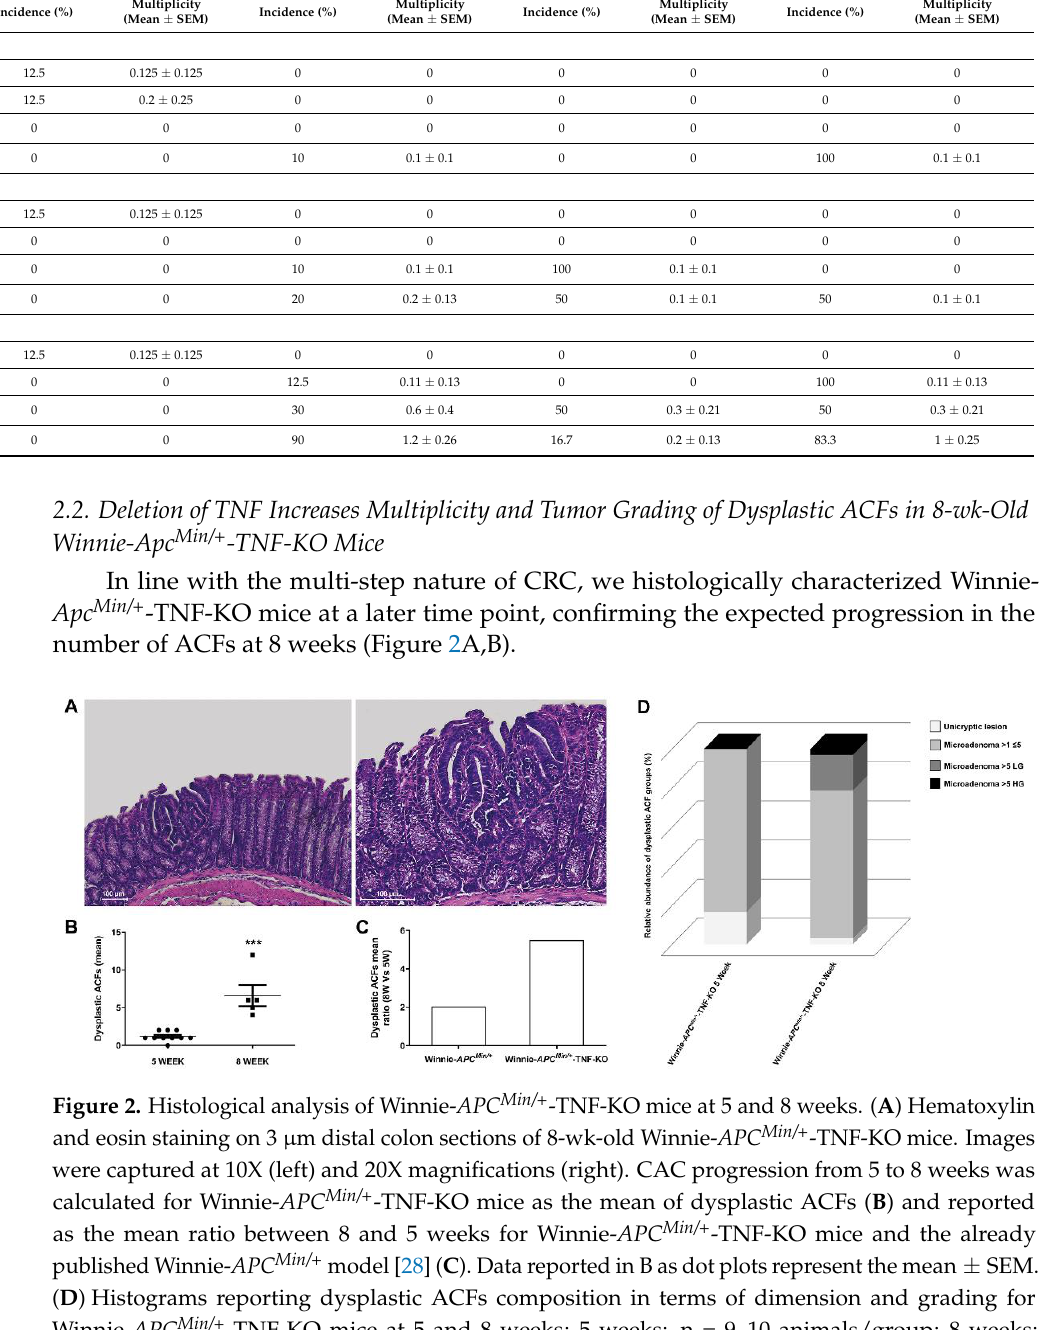
Table 1. Histological analysis of 5-week-old Winnie- APC Min/+ -TNF-KO mice and control littermates. Incidence and multiplicity ± SEM of proximal, medial, and distal colon were calculated for non- dysplastic and dysplastic ACFs. The score for dysplastic ACFs was calculated relative to all groups, and each group of neoplastic lesions was classified according to the dimension and grading in the unicryptic lesions and microadenoma: >1 ≤ 5 crypts LG; TNF: tumor necrosis factor; ACFs: aberrant crypt foci; LG: low grade.